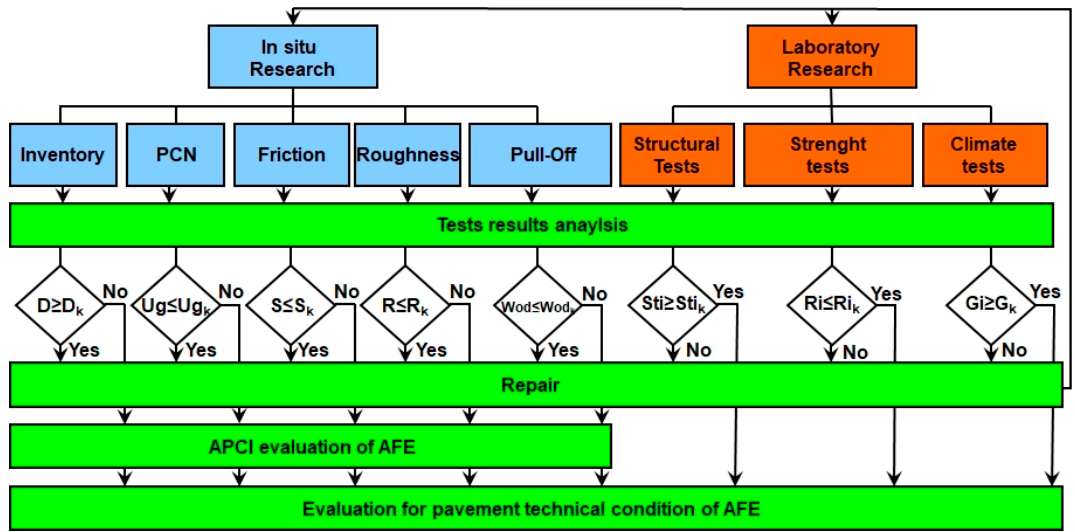
Figure 3. Evaluation of the pavement technical condition of the airport functional elements (AFE). Abbreviations: APCI, Airport Pavement Condition Index; PCN, Pavement Classification Number.